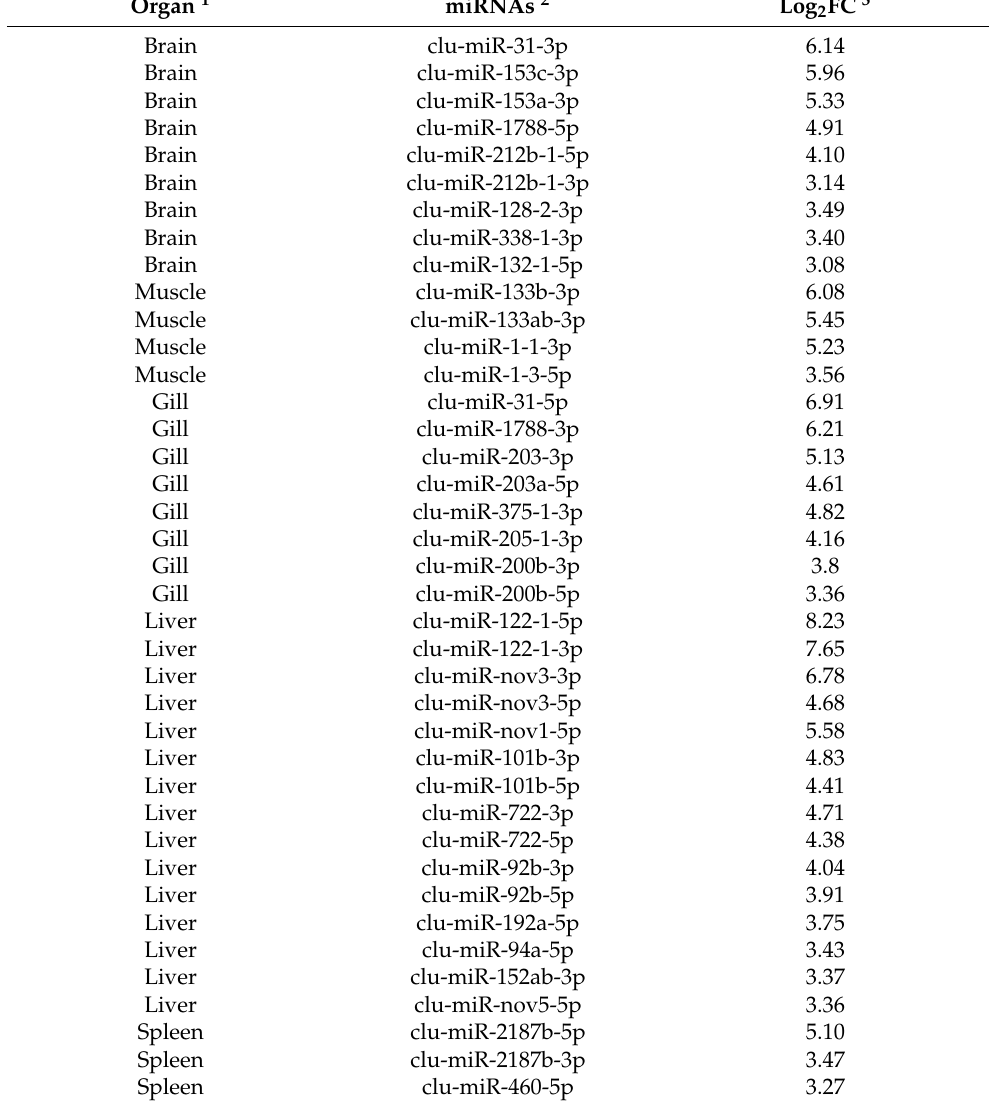
Table 2. Mature miRNAs suggested as highly expressed in one organ compared to